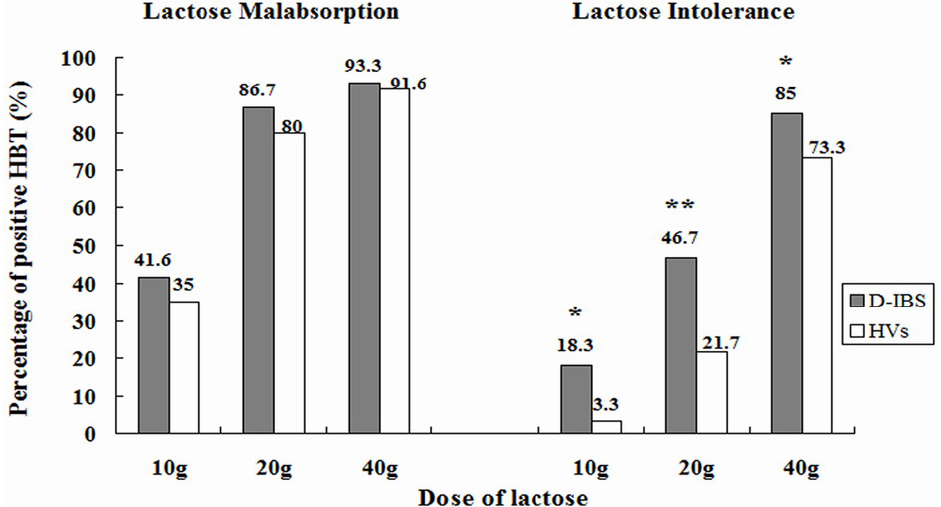
Figure 3. Prevalence of lactose malabsorption (LM) and lactose intolerance (LI) in patients with diarrhea predominant irritable bowel syndrome (IBS-D) and controls at 10-, 20-, and 40-g lactose hydrogen breath test (HBTs). * p < 0.05; ** p < 0.01 [31].